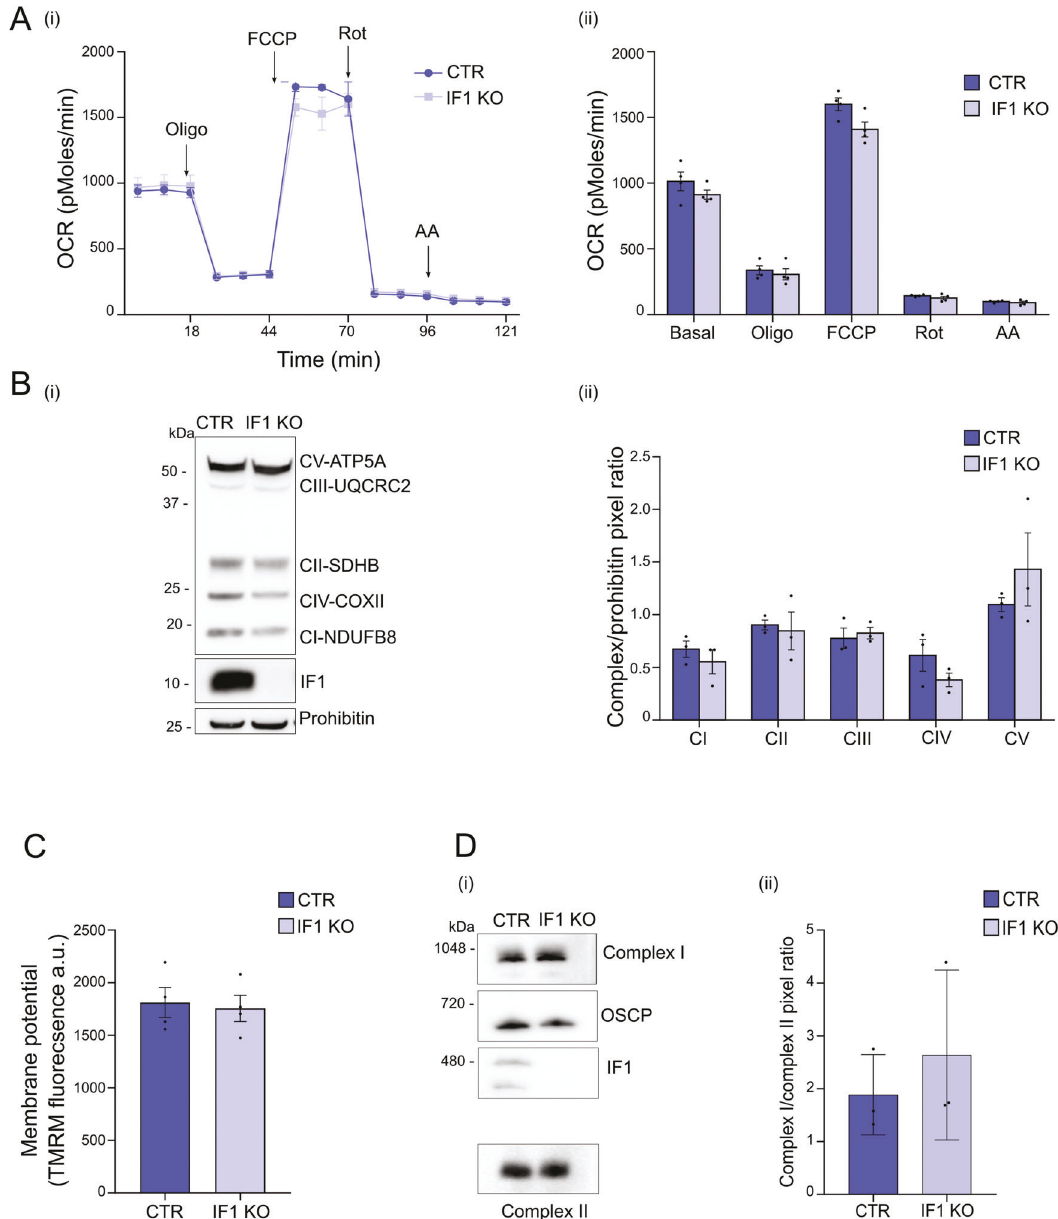
Fig. 6 Knocking out the IF1 inhibitor protein in HeLa cells does not affect mitochondrial function. A Oxygen consumption rate (OCR) is shown for CTR and IF1 KO HeLa cells. OCR is measured before (basal) and after treatment with oligomycin (oligo), carbonyl cyanide p- (tri fl uoromethoxy) phenylhydrazone (FCCP), rotenone (Rot) and antimycin A (AA). In (i), a representative OCR measurement of adherent HeLa cells in situ, seeded at the concentration of 50,000 cells/well. In (ii), mean OCR ± SEM of four independent experiments. B Western blotting (i) is shown of the indicated OXPHOS complex subunits, IF1 and prohibitin (loading control) in CTR and IF1 KO HeLa cells. The molecular marker is indicated on the left. In (ii), the mean ratio is analyzed of band pixels between each complex subunit and prohibitin (mean ± SEM of three independent experiments). C Quanti fi cation is shown of TMRM fl uorescence monitoring the mitochondrial membrane potential in intact CTR and IF1 KO HeLa cells. Data are expressed in arbitrary units (a.u.) and are mean ± SEM of four independent experiments. D Western blotting of BN-PAGE (i) performed on mitochondrial extracts from CTR and IF1 KO HeLa cells (1% w/v digitonin) is shown for NDUFS1 complex I subunit, SDHA complex II subunit, OSCP, and IF1. Molecular markers are on the left. In (ii), the mean ratio (three independent experiments ± SEM) is shown between complex I- containing supercomplexes and complex II band pixels in CTR and IF1 KO